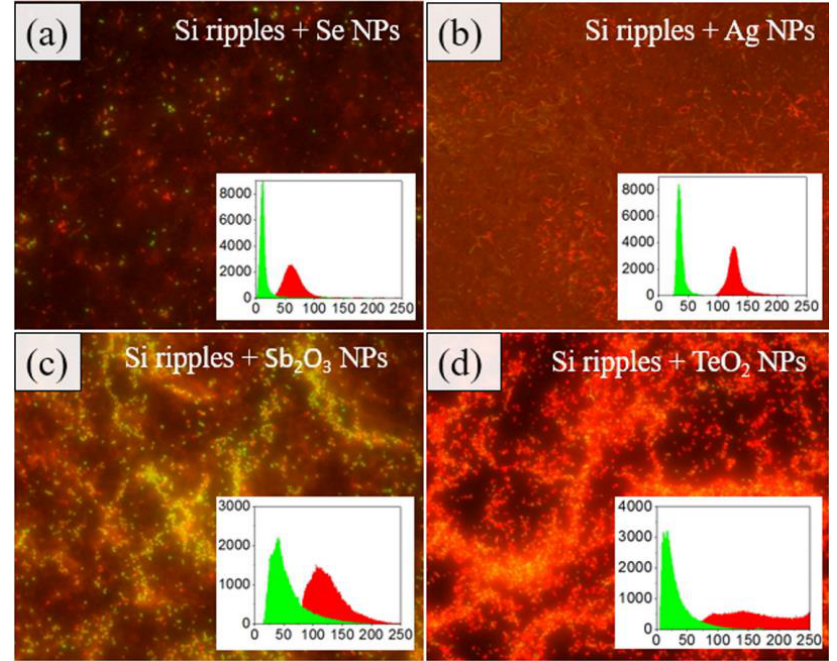
Figure 7. Fluorescent microscope photographs of dye-stained S. aureus bacteria cultured on Si ripples covered with ( a ) Se NPs, ( b ) Ag NPs, ( c ) Sb 2 O 3 NPs, and ( d ) TeO 2 NPs. (Reproduced with permission from [113]. IOP Publishing, 2020).